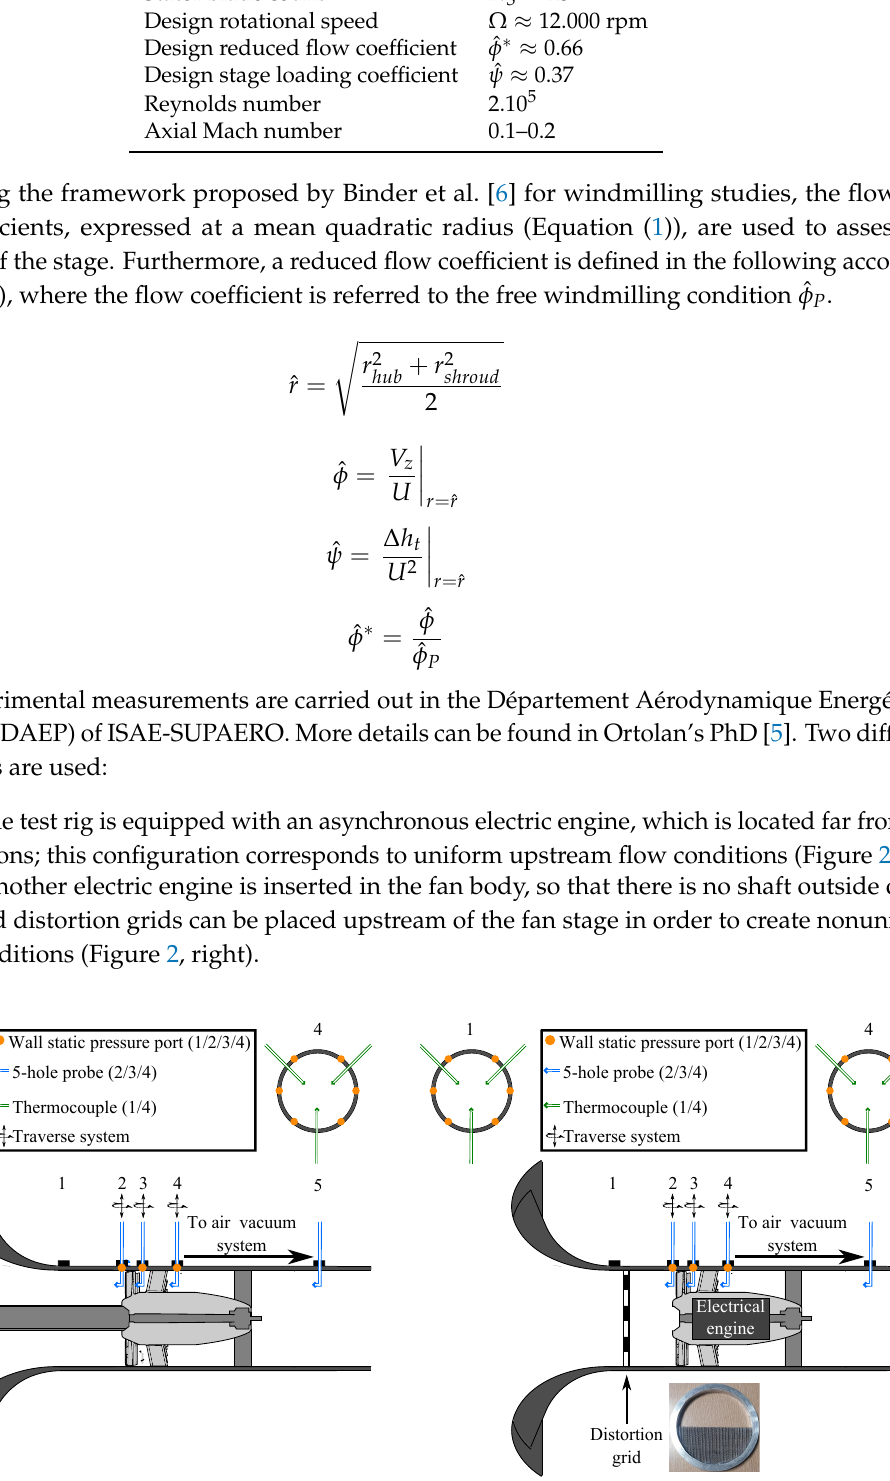
Figure 2. Schematic of the two experimental configurations, without/with